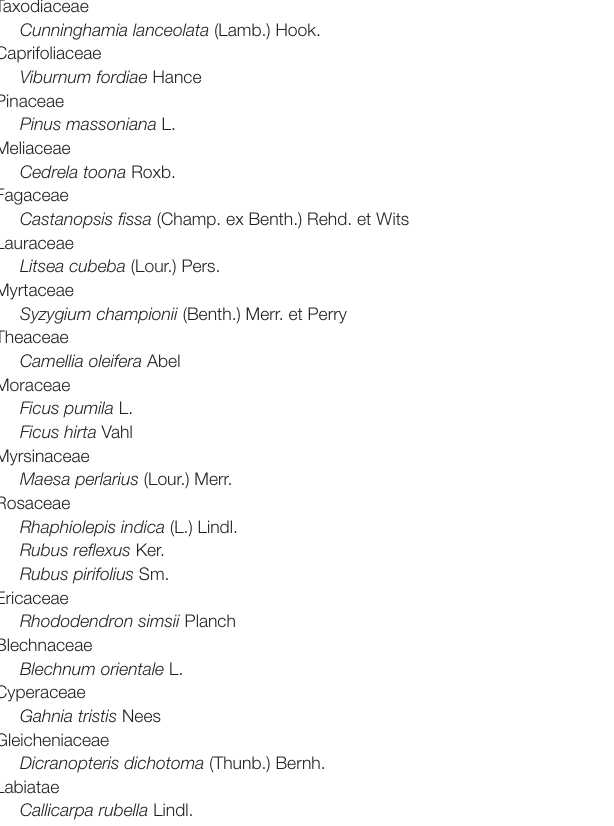
TABLE 3 | Modern plant species around Dahu swamp (Zhong et al.,